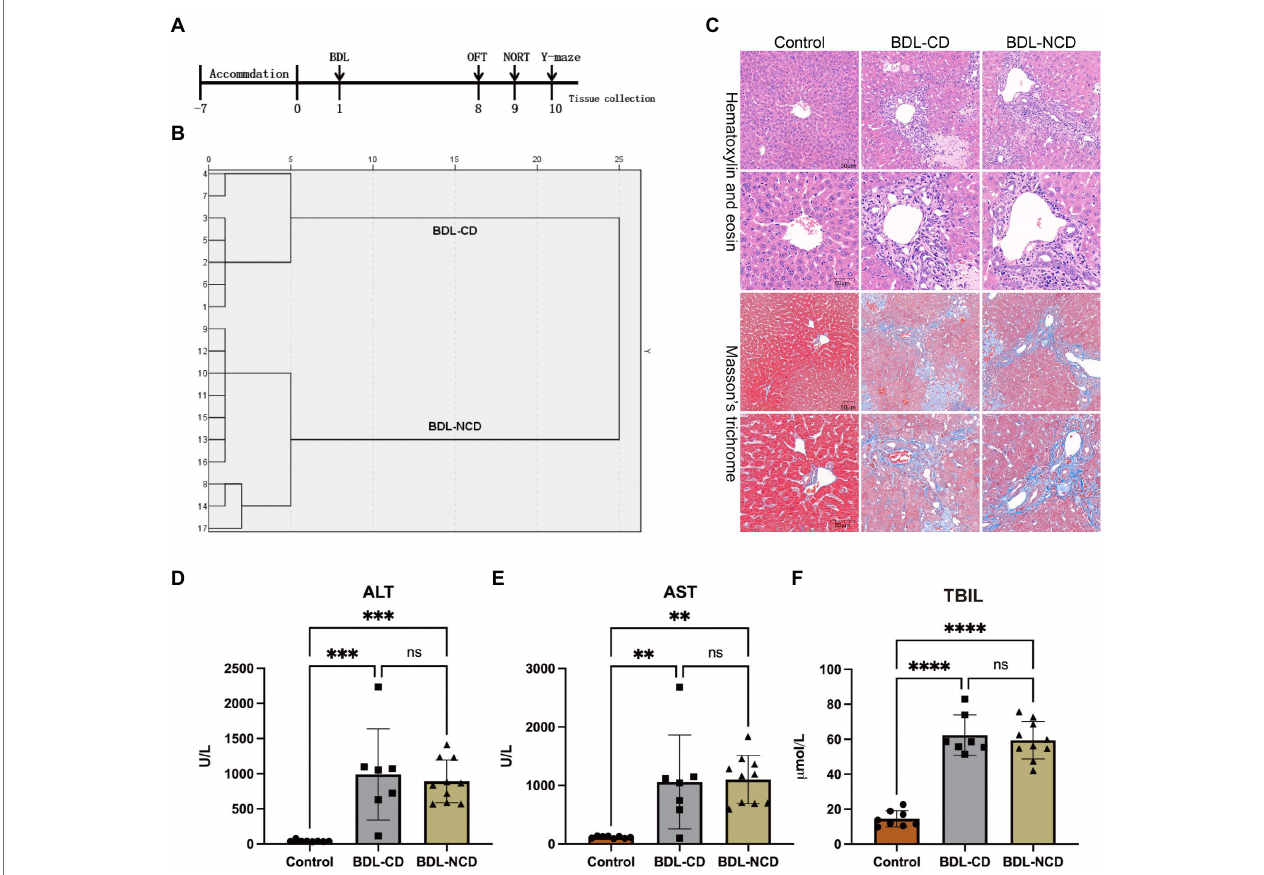
FIGURE 1 | Biochemical and histological changes in the liver in the BDL group. (A) Timeline of the BDL model and behavior tests. Ligation of the bile duct in the mice was performed after 7 days of accommodation. The OFT, NORT, and Y-maze tests were carried out on days 8, 9, and 10, respectively. Tissue was collected after the behavior tests. (B) Dendrogram of the hierarchical clustering analysis. A total of 17 BDL mice were divided into cognitive dysfunction (BDL-CD, n = 7) and no cognitive dysfunction (BDL-NCD, n = 10) groups according to the results of hierarchical clustering analysis on NORT results. Before tissue was collected, one mouse died in the BDL-NCD group. (C) Hematoxylin & eosin and Masson’s trichrome stained sections of the liver. (D) Serum ALT levels. (E) Serum AST levels. (F) Serum TBIL levels. ALT, alanine aminotransferase; AST, aspartate aminotransferase; and TBIL, total bilirubin. Data are presented as the mean ± SEM. ** p < 0.01; *** p < 0.001; **** p < 0.0001; and ns, not